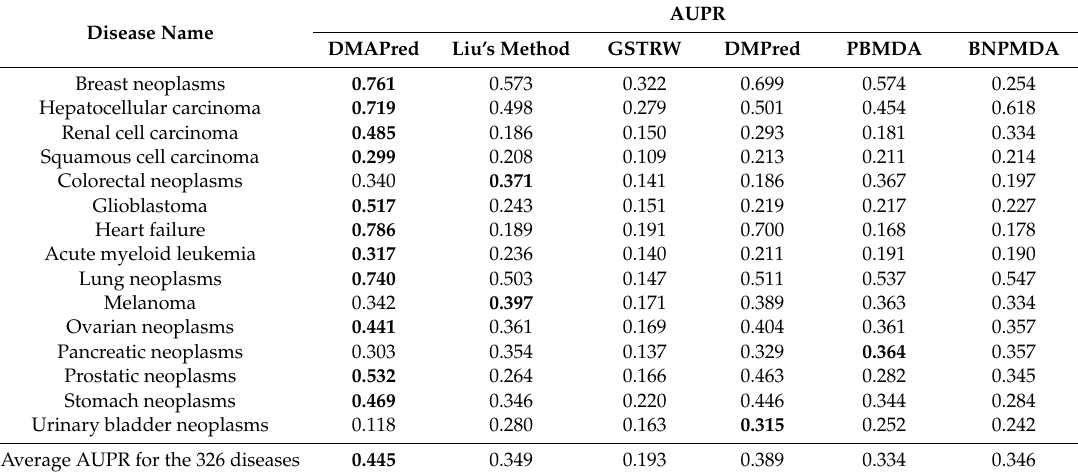
Table 2. AUPR values of five methods for all the diseases and 15 common diseases. Disease